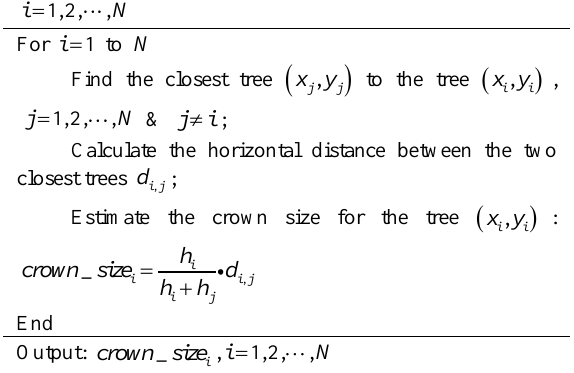
Table 1 . Flowchart of the crown size estimation